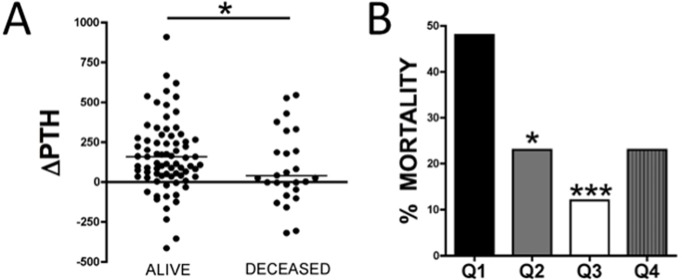
Changes in iPTH (ΔiPTH,pg/ml) during the first 12 months and mortality at 24 months.(A) Comparison of ΔiPTH within the first 12 months between survivors and deceased patients at 24 months. The mean ΔiPTH was higher in survivors than in deceased patients. * P <0.05. (B) Graphic representation of mortality according to quartiles of ΔiPTH in the first year: Q1 ΔiPTH <0 pg/ml; Q2 0–100 pg/ml; Q3 101–300 pg/ml; Q4 >301 pg/ml. * P <0.05 *** p <0.001 vs Q1.